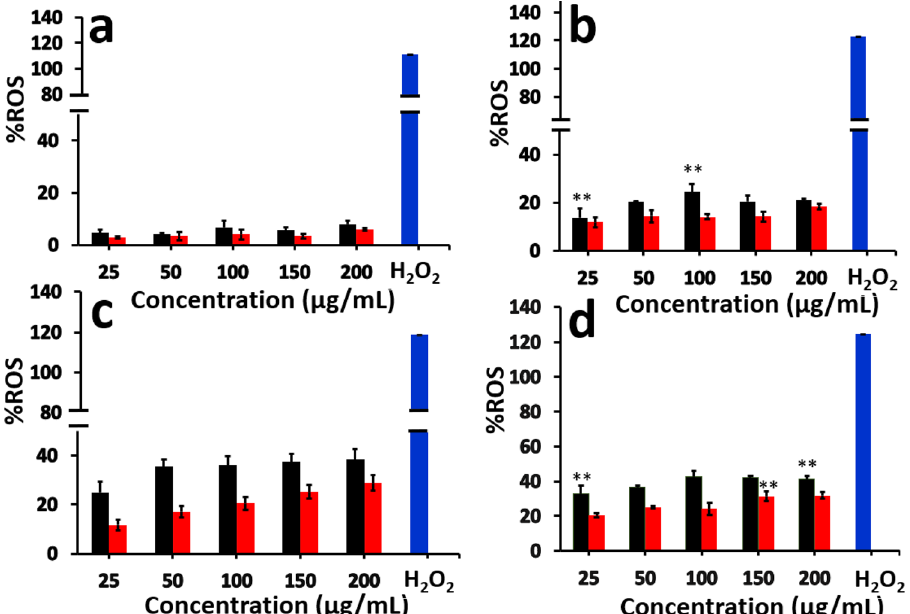
Figure 9. Concentration of ROS produced in BHK-21 cells after ( a ) 24 h, ( b ) 48 h, ( c ) 96 h and ( d ) 120 h of incubation with PVC ( ■ ) and PMMA ( ) NPs at different concentrations. The data for 72 h incubation were given in the supporting information, Figure S9. The results are given as % of the ROS production with respect to the control (untreated cells) and are the mean ± SEM of three experiments. Statistical analysis was done by one-way ANOVA (* p < 0.05, ** p < 0.01, *** p < 0.001, **** p < 0.0001) compared to control cells with no particles